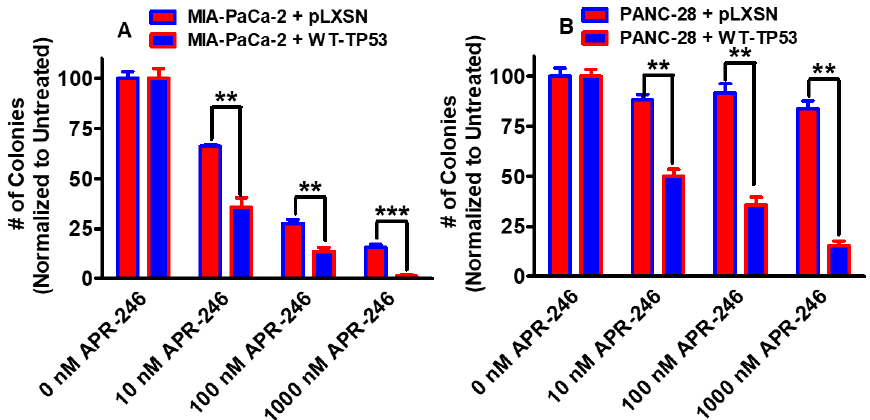
Figure 2. Effects of APR-246 on clonogenicity of PDAC cells containing and lacking WT-TP53 or mutant GOF TP53. Panel ( A ) MIA-PaCa-2 + pLXSN cells (red bars), MIA-PaCa-2 + WT-TP53 cells (blue bars). Panel ( B ) PANC-28 + pLXSN cells (red bars), PANC-28 + WT-TP53 cells (blue bars). Cells